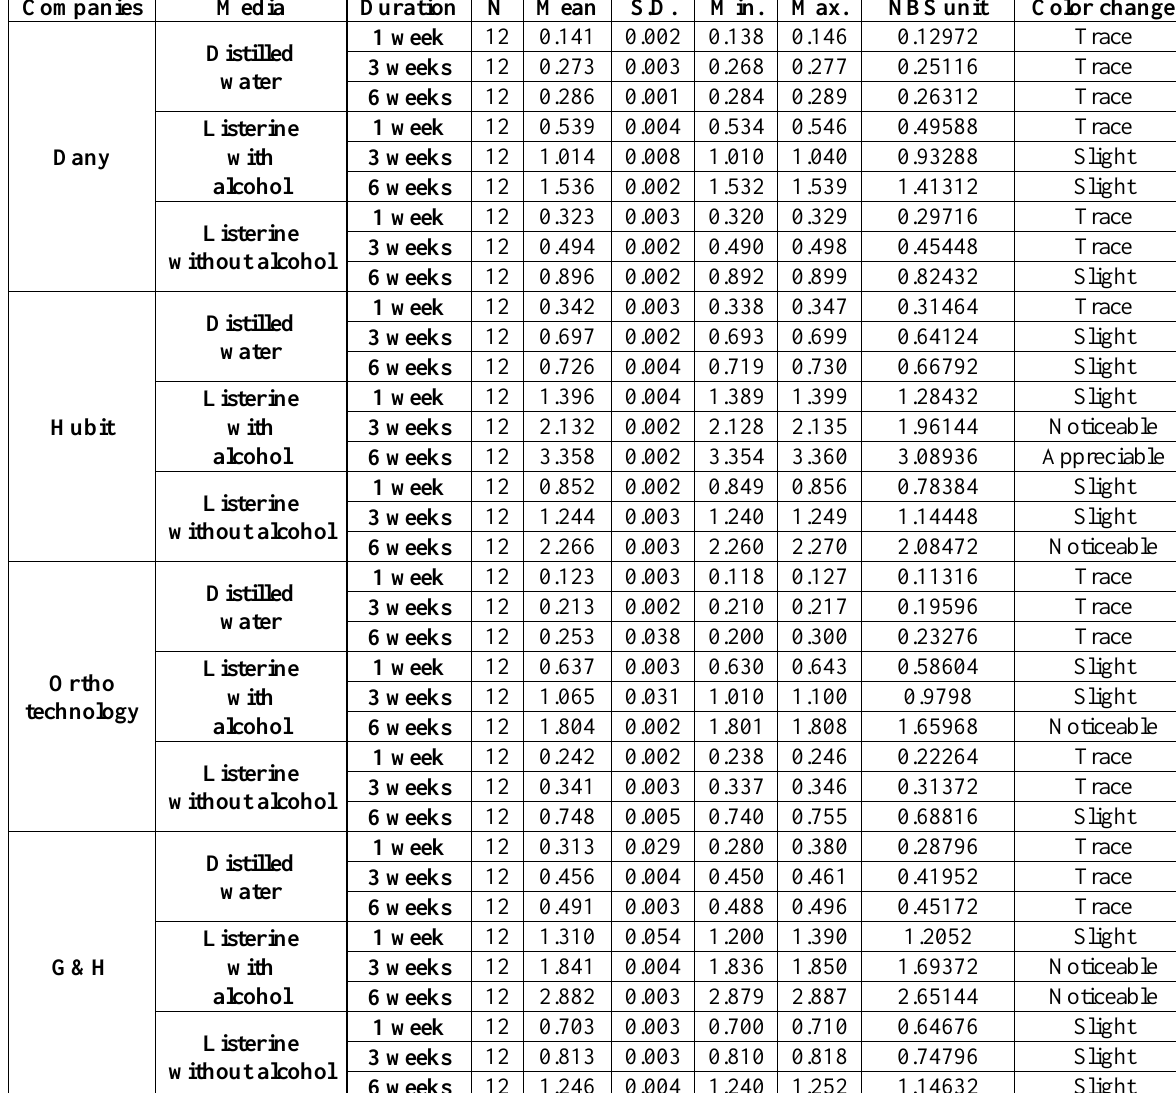
Table 1: Descriptive statistics of ΔE* values and National Bureau of Standards (NBS) units of aesthetic arch wires in various immersion media at differenttime intervals.